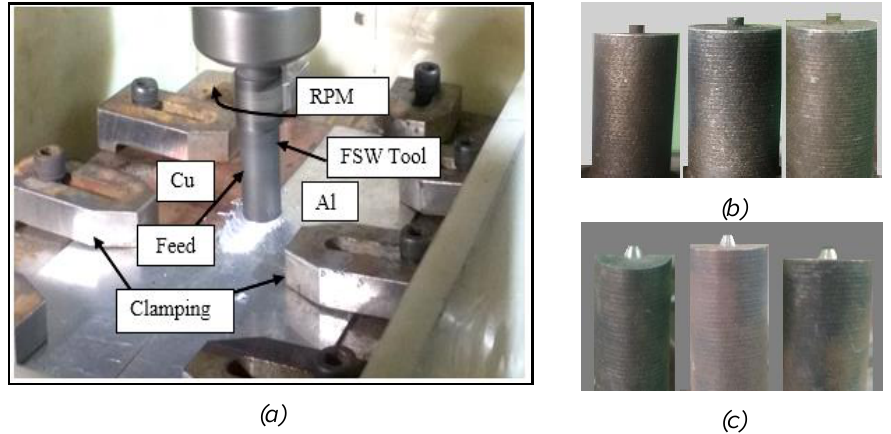
Fig. 1. FSW Experimental set-up (a) Setup with fixture (b) Cylindrical Pin tool (c) Tapered Pin